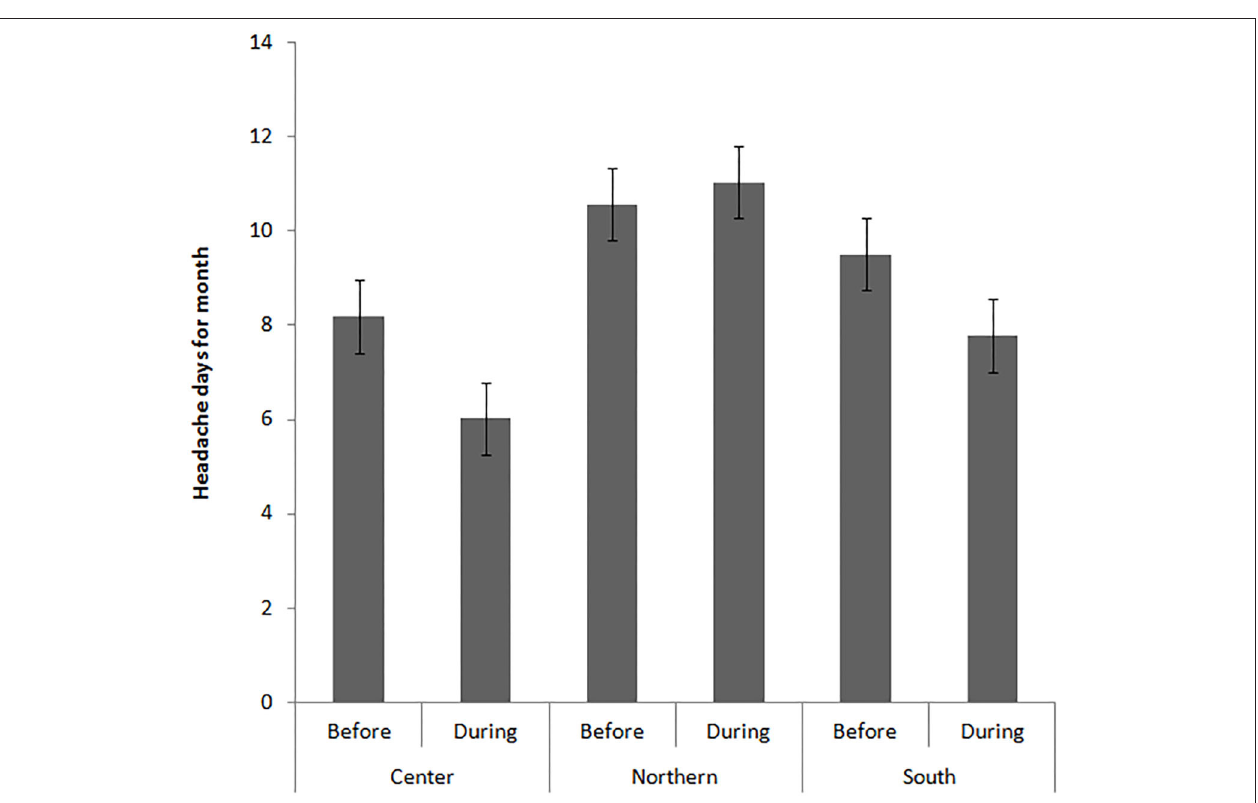
FIGURE 1 | Mean and standard errors of headache frequency, expressed in number of headache days for month, before and during the quarantine in the different Italian geographic areas. Statistical analysis is reported in Table 3 .